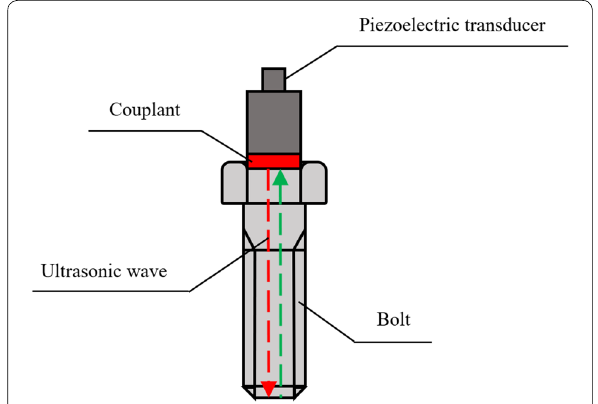
Figure 8 Schematic diagram of ultrasonic testing